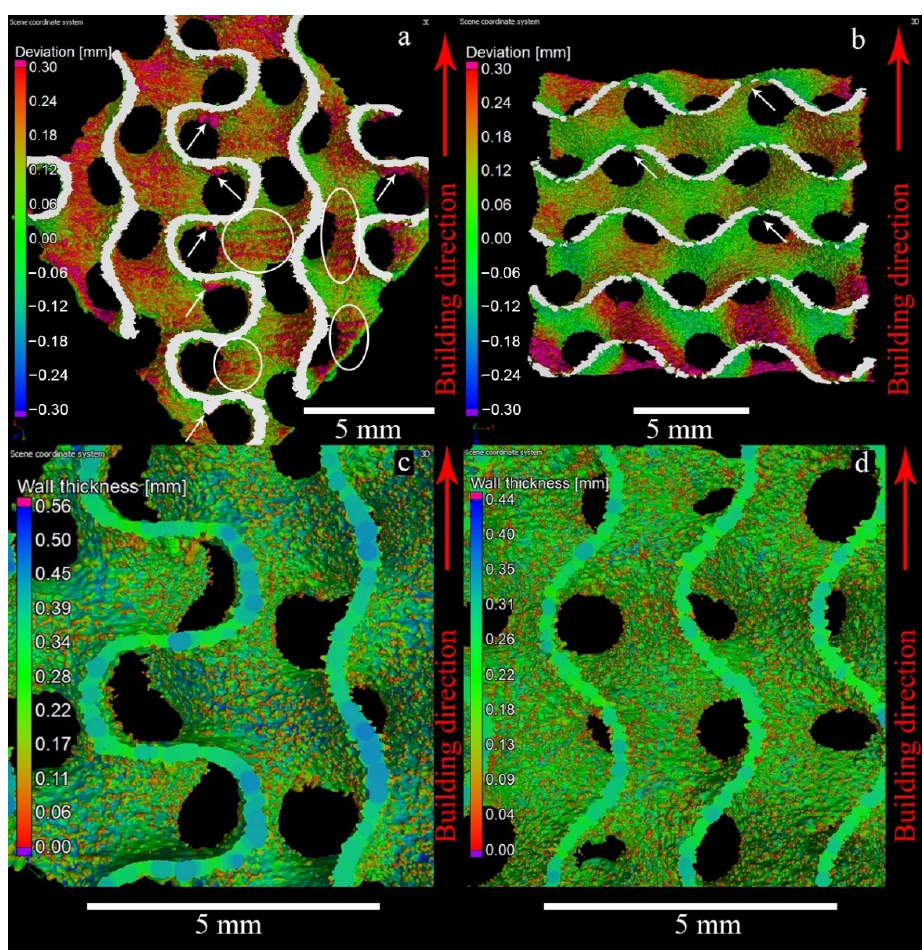
Figure 4. 3D rendering of the CT reconstructions for the Nominal/Actual Comparison of the MT gyroid ( a ) and WT gyroid ( b ). Visualization of the wall thickness for the MT gyroid ( c ) and WT gyroid ( d ). White arrows indicate stalactite-like structures on the horizontally oriented parts of the MT walls (areas parallel to the layers, purple color). The white circles highlight the partially melted powder particles attached to the surface of the vertical